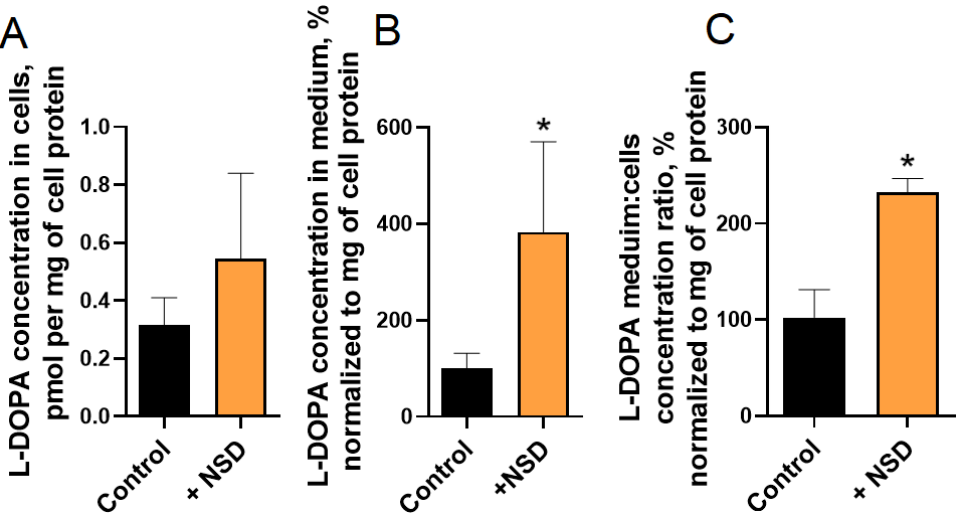
Figure 6. The concentration of L-DOPA in LUHMES cells ( A ), incubation medium ( B ), and their ratio ( C ) following cell incubation in artificial cerebrospinal fluid containing 500 µ M of 3-hydroxybenzylhydrazine dihydrochloride (NSD-1015). * p < 0.05, significant difference compared to the control.